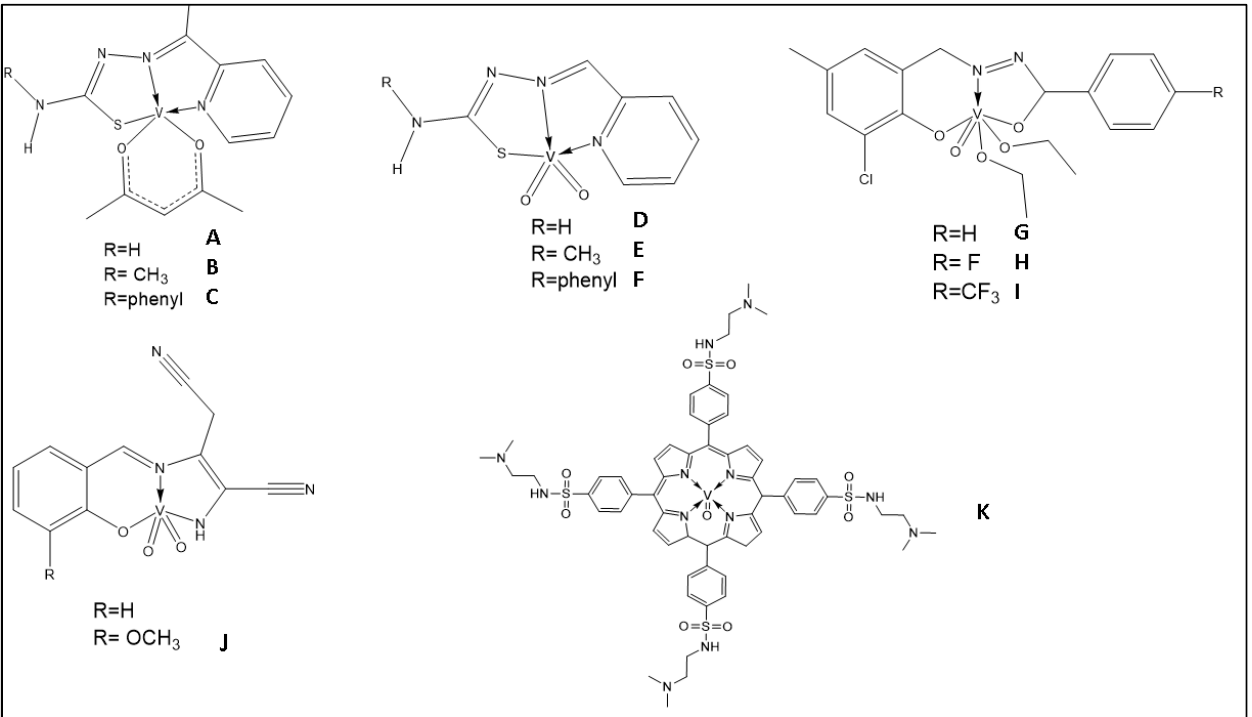
Figure 6. The structure of oxovanadium complexes with antimicrobial potency.